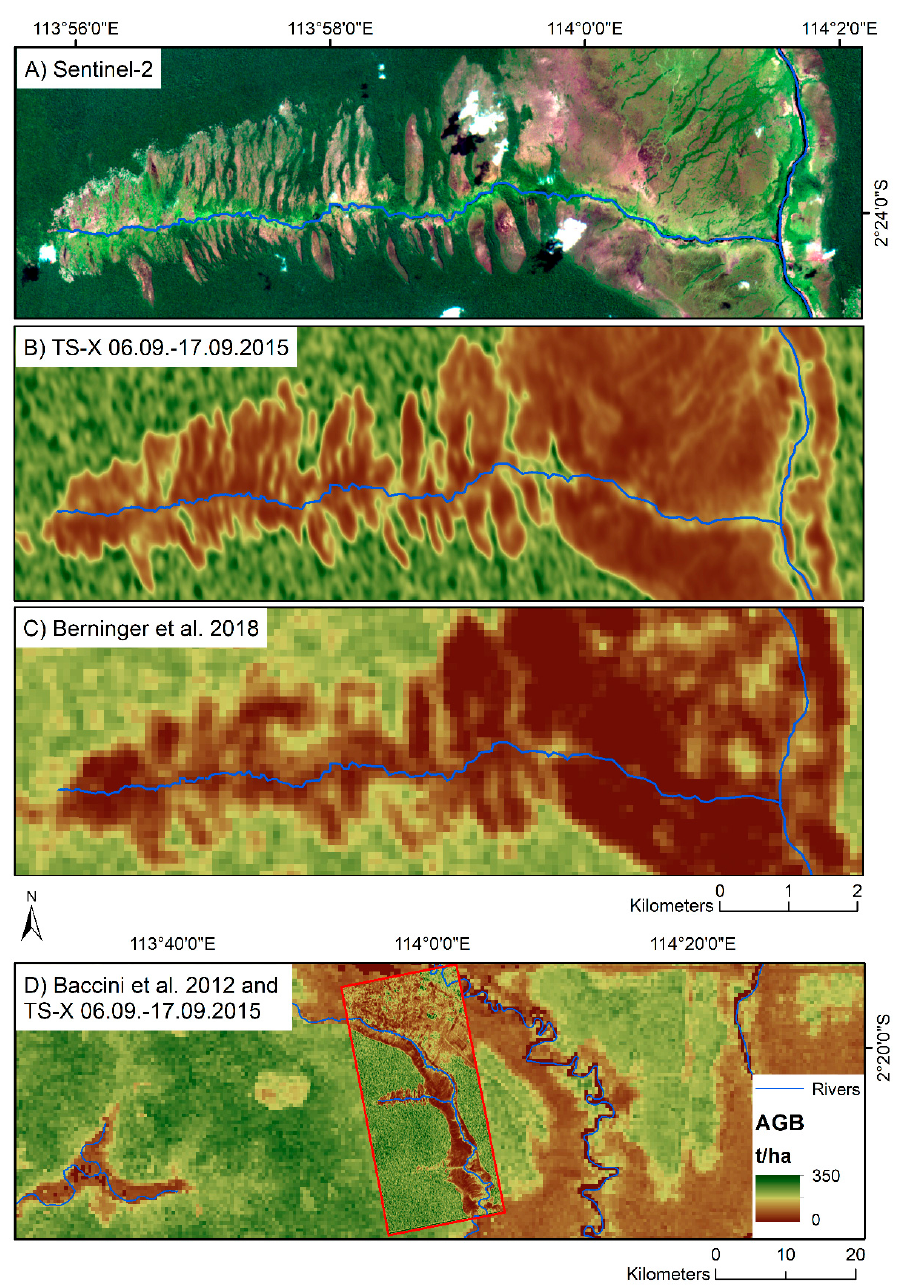
Figure 10. Comparison between di ff erent biomass maps. ( A ) True-color image of Sentinel-2 showing a wetland in the Sebangau National Park, Central Kalimantan. ( B ) AGB with a resolution of 3 m modelled based on TerraSAR-X images from 06.09.-17.09.2015. ( C ) AGB with a resolution of 100 m, modelled by Berninger et al. [50] using ALOS PALSAR and Sentinel-1 from 2015. ( D ) AGB with a resolution of 500 m, modelled by Baccini et al. [51] based on ICE-Sat data from 2007 through 2008 and the TS-X based AGB results are from 06.09.–17.09.2015 (framed in red).